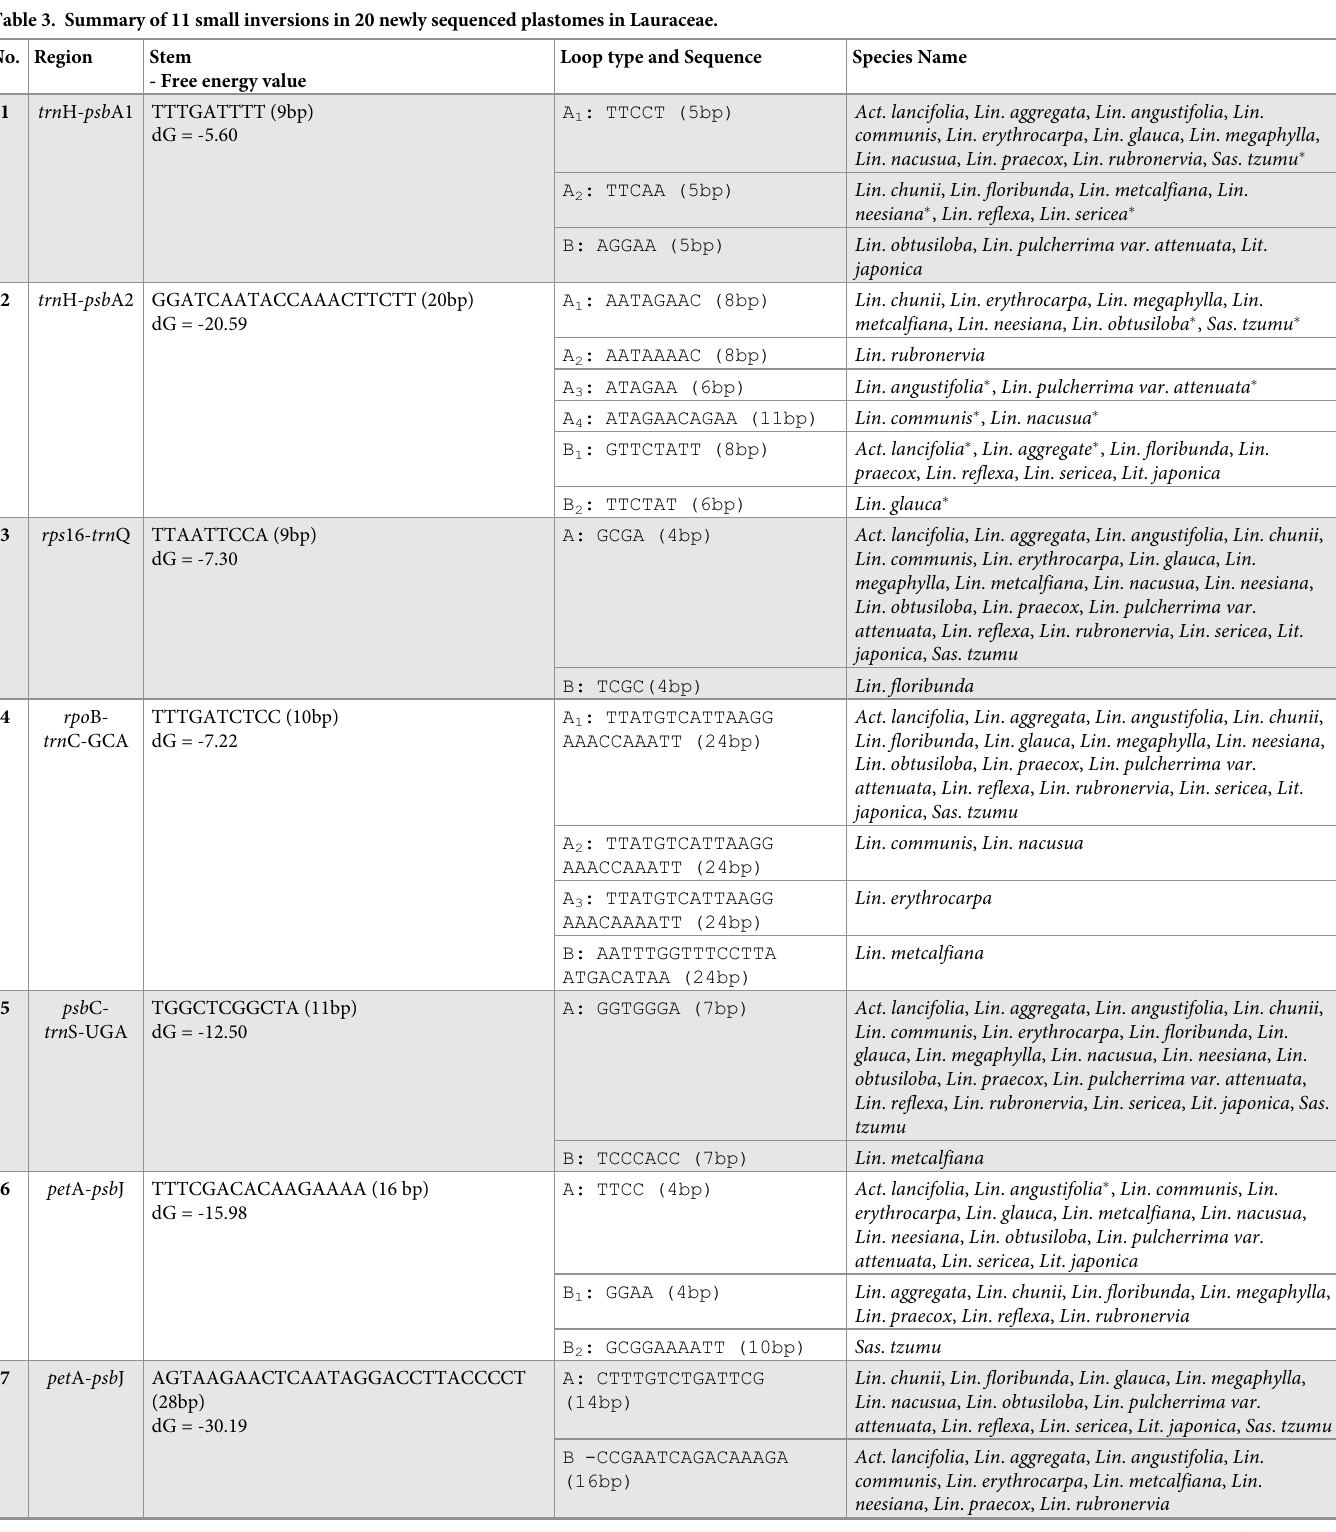
Table 3. Summary of 11 small inversions in 20 newly sequenced plastomes in